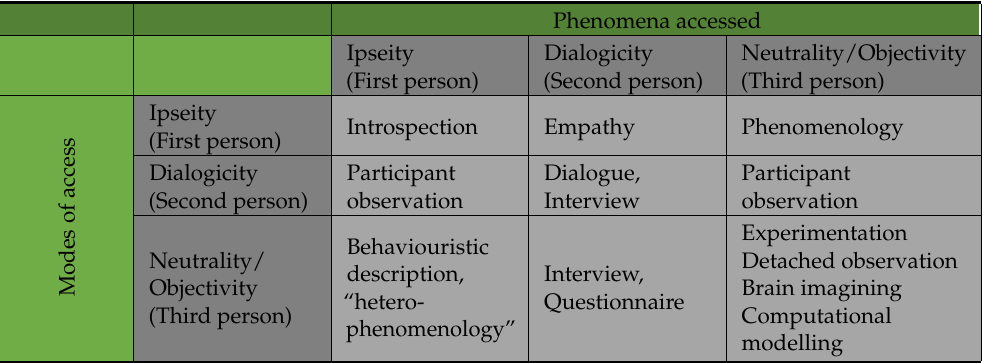
Table 1. The distinction of ipseity, dialogicity, and neutrality in the phenomena accessed and the modes of access (adapted from Sonesson [21] as an extension of Zlatev [22] (p. 1059)). Note that this division into triadic categories is not the same as that made by Peirce, to whom both dialogicity and objectivity would be instances of Secondness. See [23]. Phenomena accessed Ipseity Dialogicity Neutrality/Objectivity (First person) (Second person) (Third person) Ipseity Introspection Empathy Phenomenology (First person) Dialogicity Participant Dialogue, observation